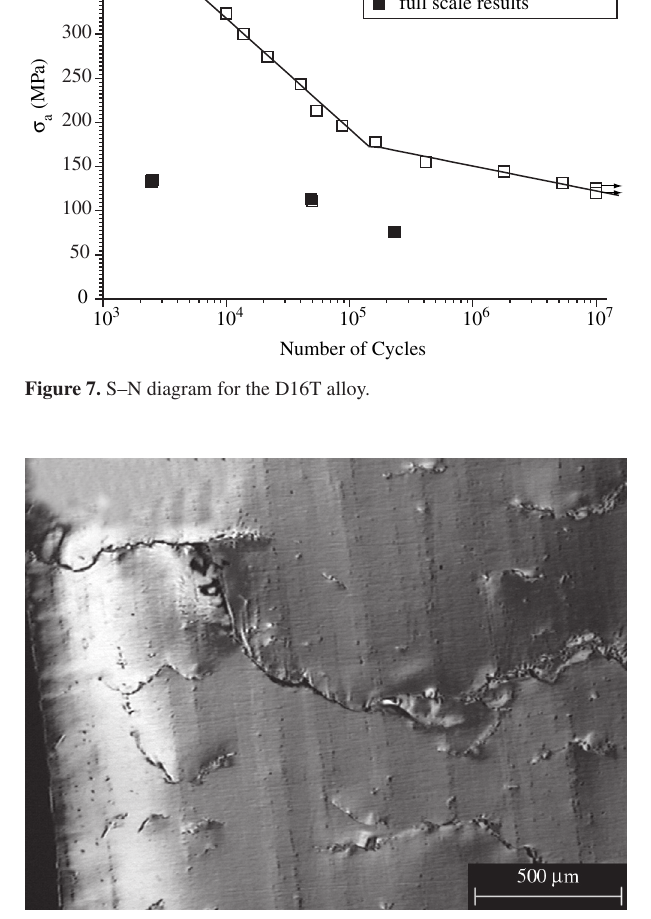
Figure 10. Fractured surface of a specimen tested at 213 MPa. Original magnification: 33X.